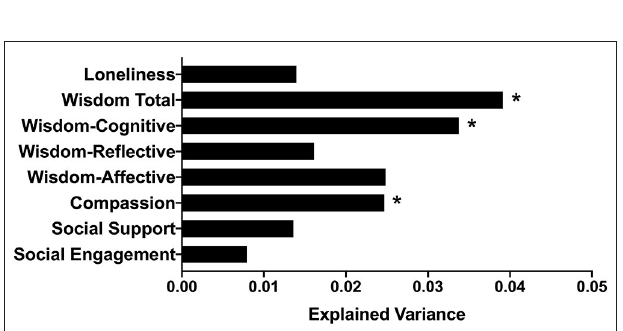
FIGURE 2 | Bar plot indicating the proportion of variance in beta-diversity (Aitchison distance) explained by each psychosocial factor, after controlling for age and BMI. * p or q <